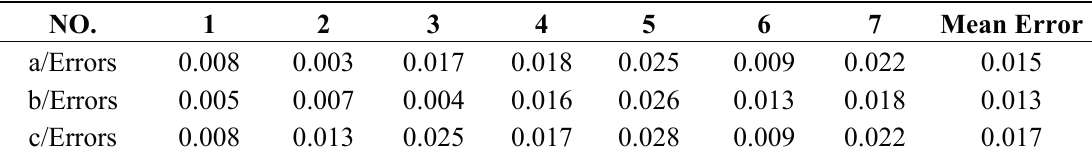
Table 8. Errors for different angles in shaft 2